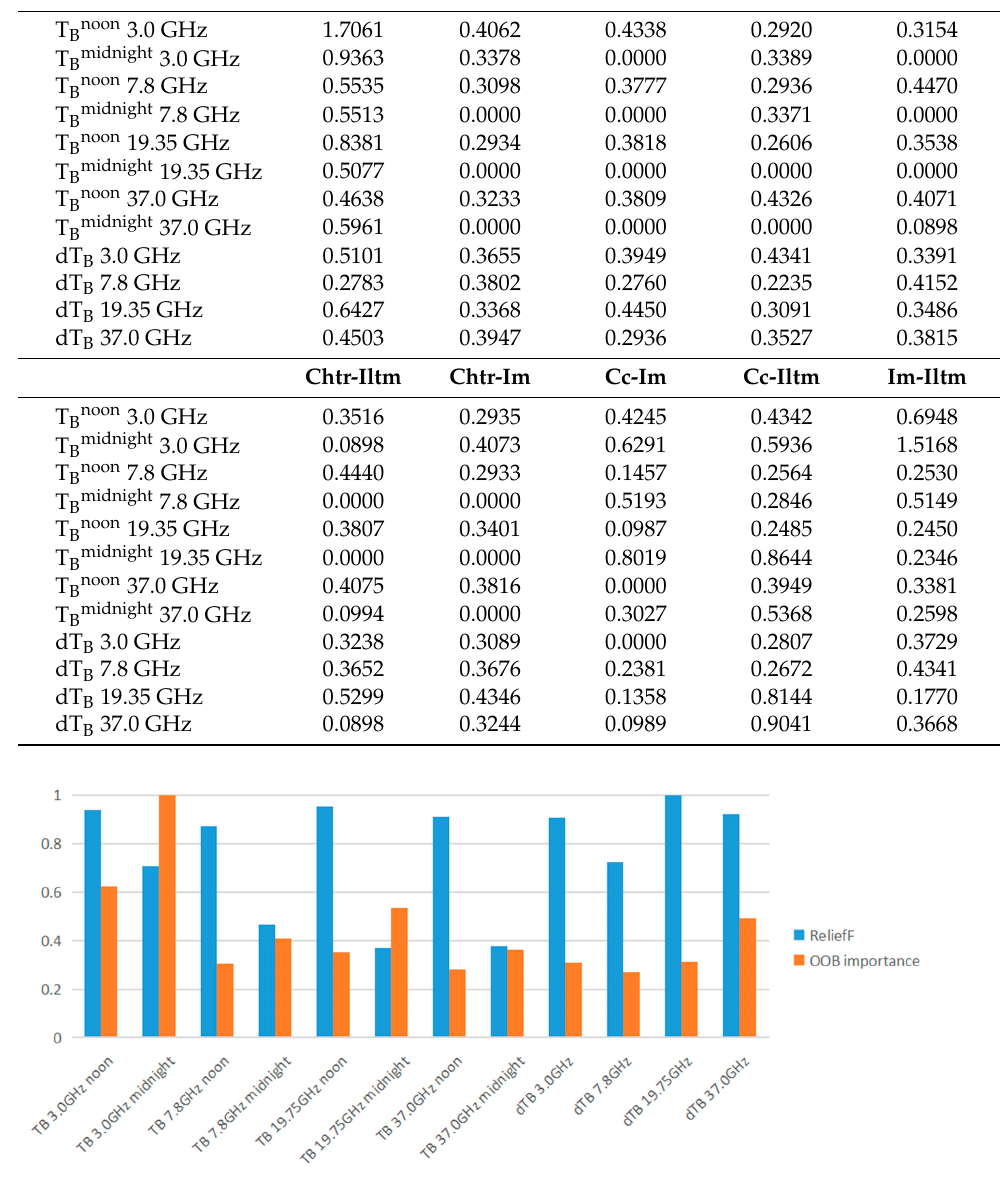
Figure 11. Normalized ReliefF and OOB importance of all